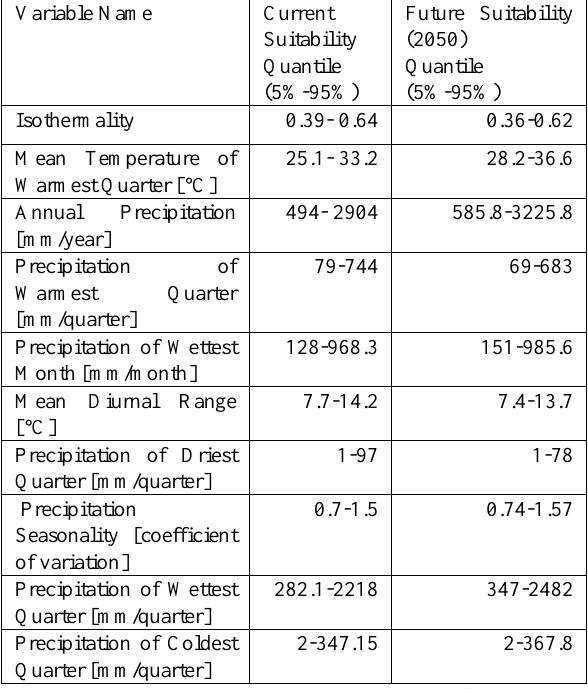
Table 3. Comparative climate change scenarios of current and